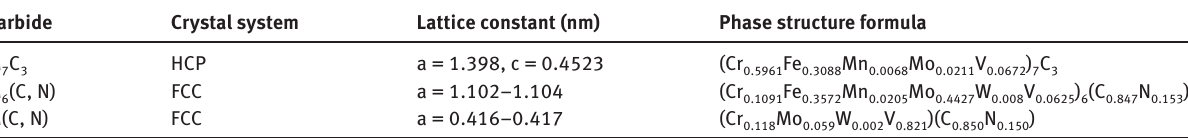
Table 2: Phase analysis result of carbides Carbide Crystal system Lattice constant (nm)